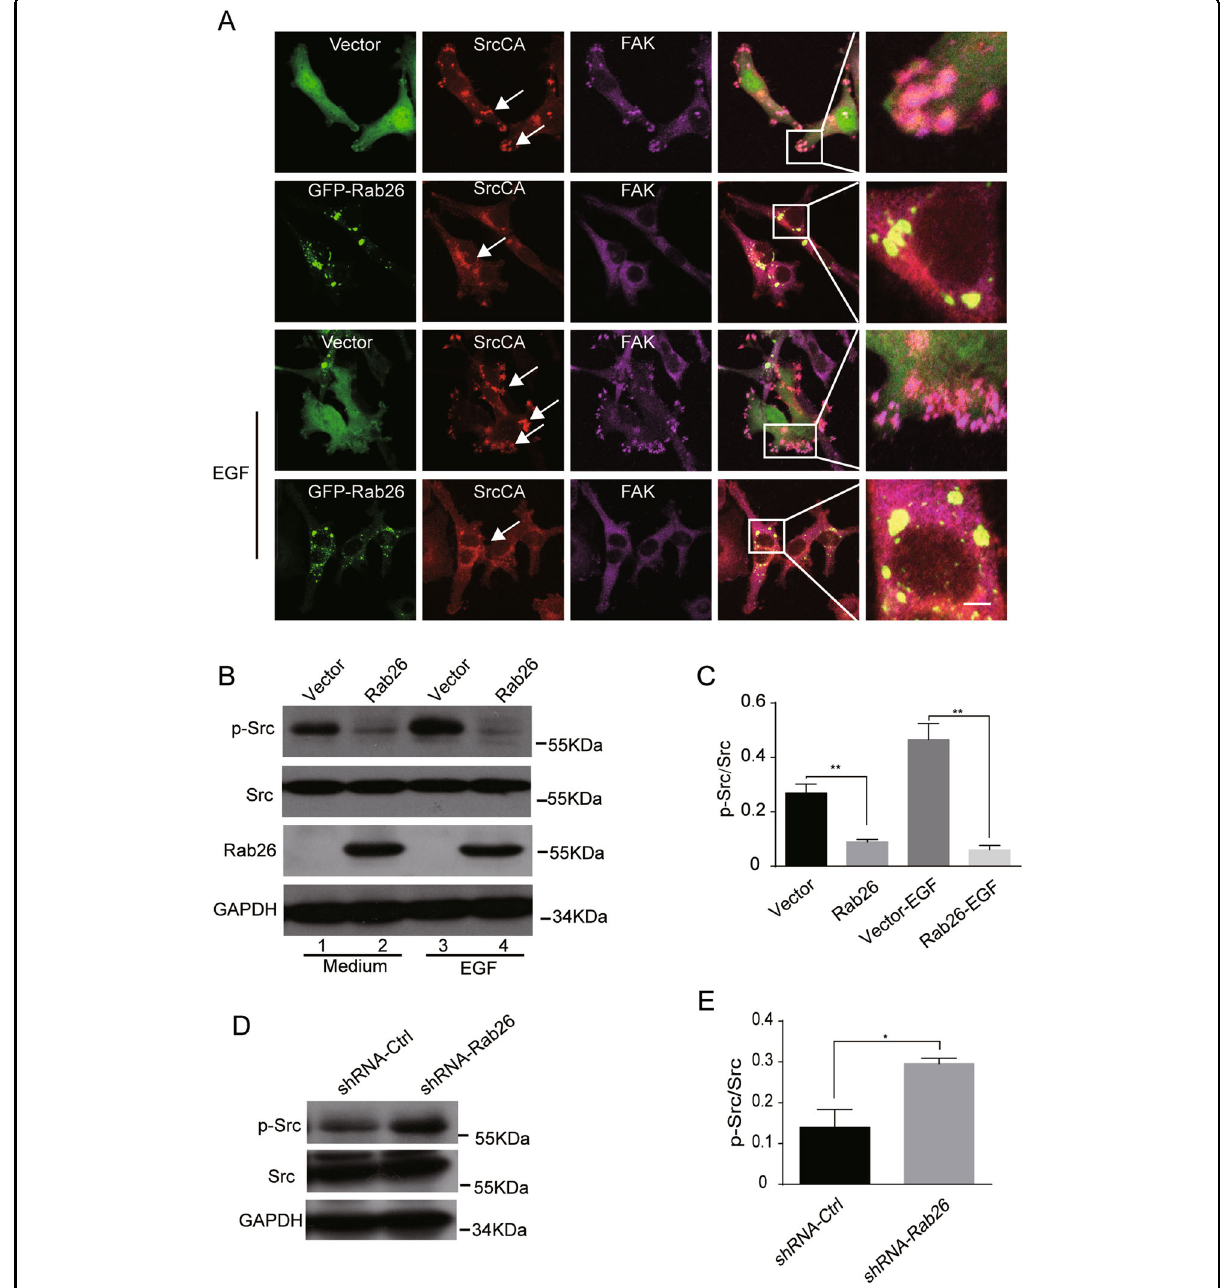
Fig. 4 Rab26 downregulates the protein level of the active Src in breast cancer cells. A MDA-MB-231 cells were co-transfected with GFP-Rab26 and pUSEamp-SrcCA; the results showed that Rab26 alters the intracellular localization of SrcCA under normal condition or EGF treatment. Bar = 20 μ m. B Western blot demonstrated over-expression of Rab26 reduces phosphorylated Src in the presence of EGF (100ng/ml) or not in MDA-MB-231 cells. C Quantitative analysis of the results of B from three independent experiments. ** p < 0.01. D Western-blot demonstrated Rab26 knockdown increases the protein level of phosphorylated Src in MCF7 cells. E Quantitative analysis of the results of D from three independent experiments. * p <